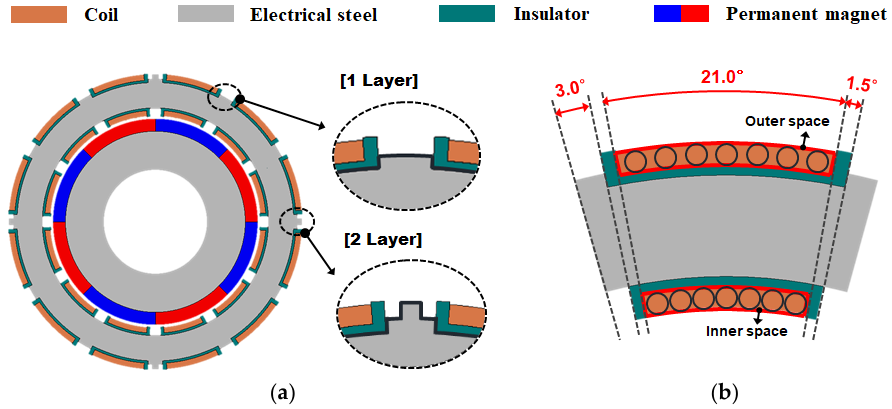
Figure 15. Structure of the prototype model: ( a ) 2D model, and ( b ) Angle of yoke protrusion and bobbin. Table 4. Prototype specification.